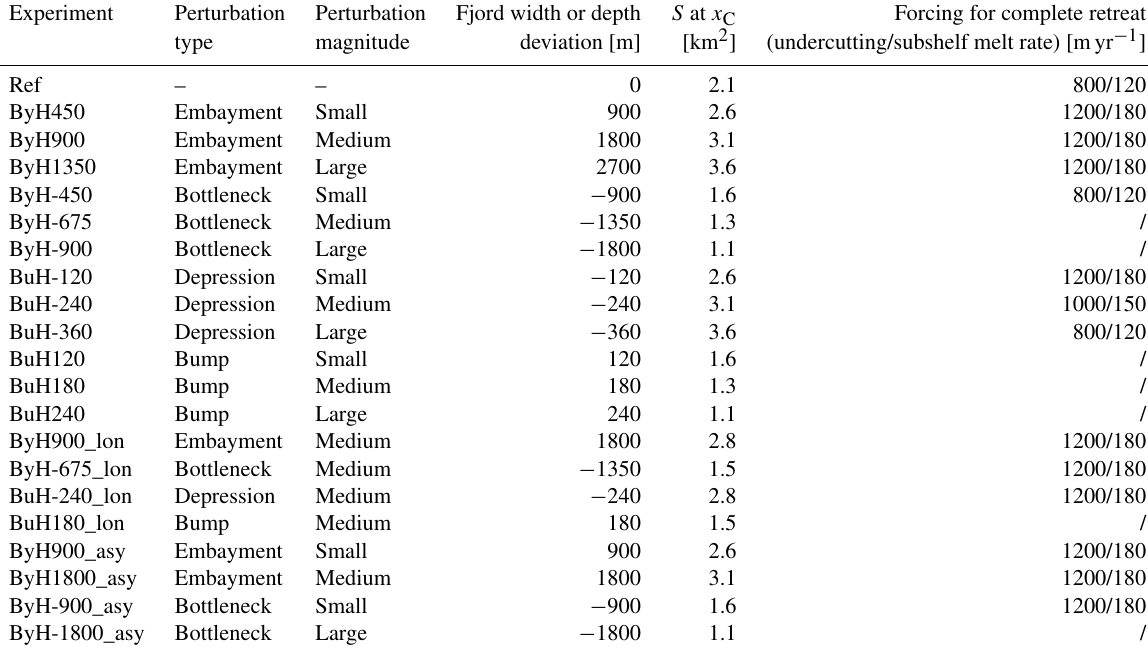
Table 2. Suite of experiments with name (extensions _lon and _asy refer to longer and asymmetric geometries), type of geometric perturba- tion, perturbation magnitude, the deviation in fjord width (2 (cid:48) for symmetric lateral perturbations, 1 (cid:48) for asymmetric ones) or depth (1 (cid:48) for basal perturbations) at the center of the perturbation relative to the linear reference fjord, S at x C (i.e., the wetted area at the center of the perturbation), and forcings required to induce complete retreat through the entire geometric perturbation (/ if no complete retreat could be